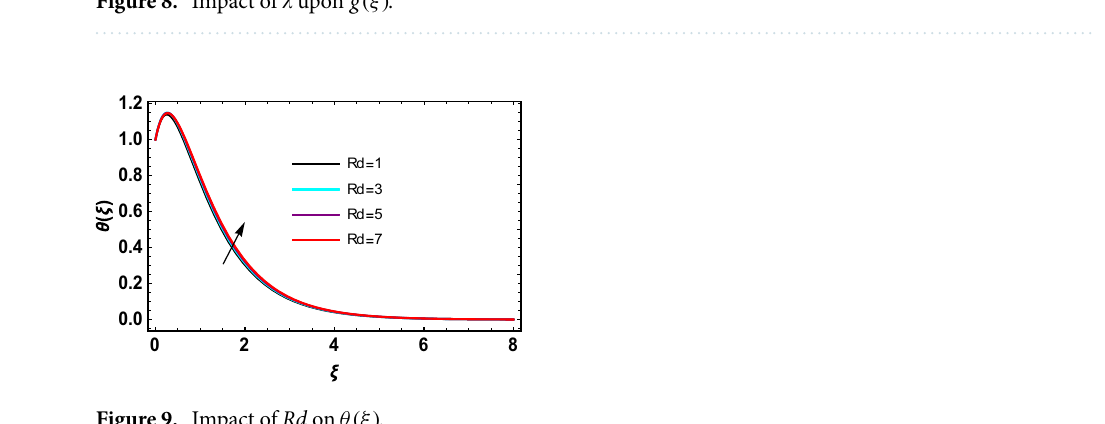
Figure 9. Impact of Rd on θ(ξ) .